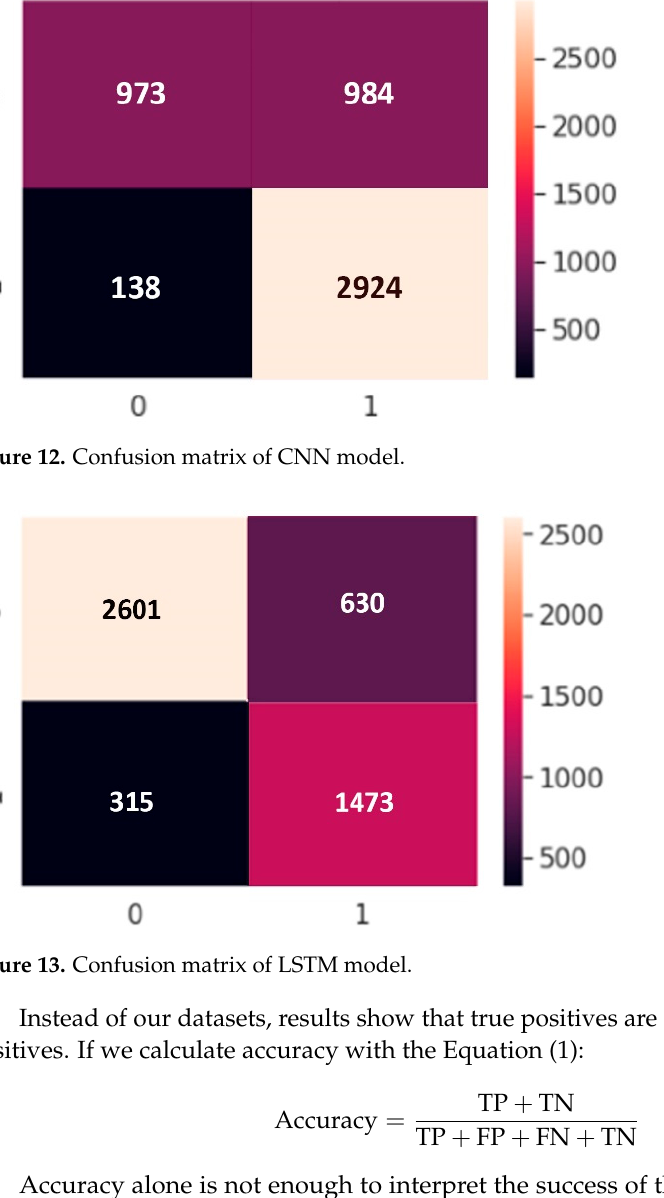
Figure 11. Confusion matrix of ANN model.